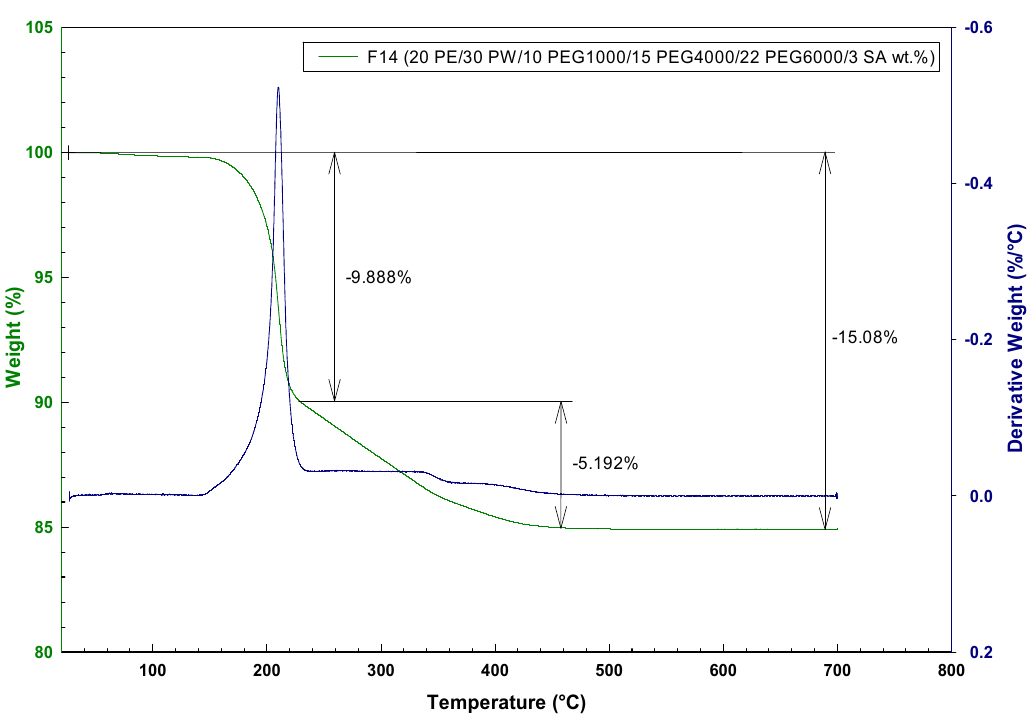
Figure 2. TGA weight loss and corresponding derivative curve for F14 (20 PE/30 PW/10 PEG1000/15 PEG4000/22 PEG6000/3 SA